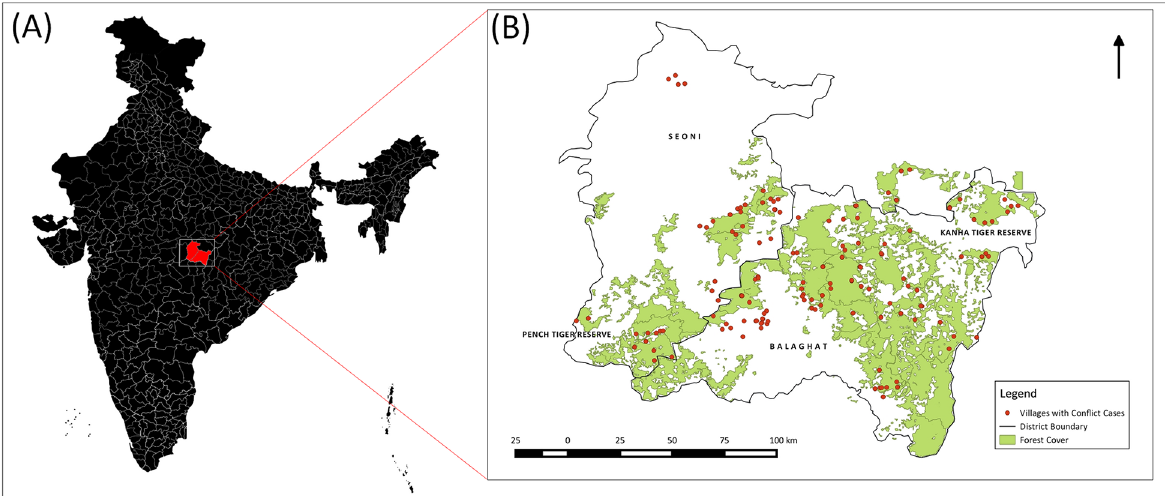
Fig 1. Map showing location of victim’s villages (markedin red) in the Kanha-Pench corridor area in India. Note: (A) Map of India, creditedto Anand S, is used with permissionto be publishedunder a CC-BY license < https://commons.wikimedia.org/wiki/File: Official_India_Map_with_Districts_2011_Census.svg > . (B) Forest cover map of Kanha-Pench corridor area (in green) showingvictim’s villages(marked in red), created under detailsprovidedby the Madhya Pradesh Forest Departmentin public domain < http://www. mpforest.gov.in > . Map not to scale and used for representational purposeonly. Map created in QGIS 2.0.